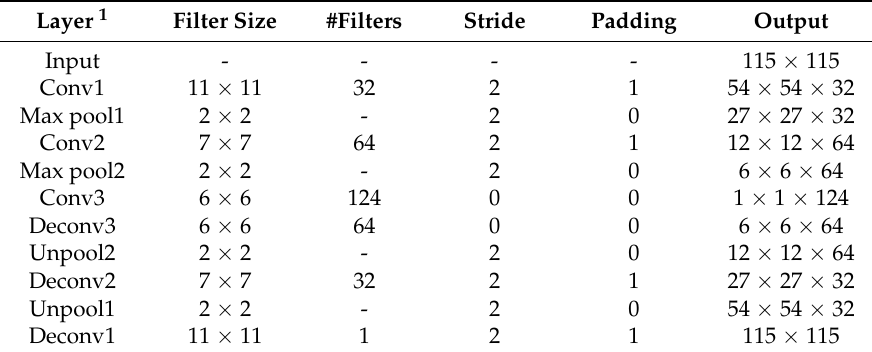
Table 1. Architecture of the